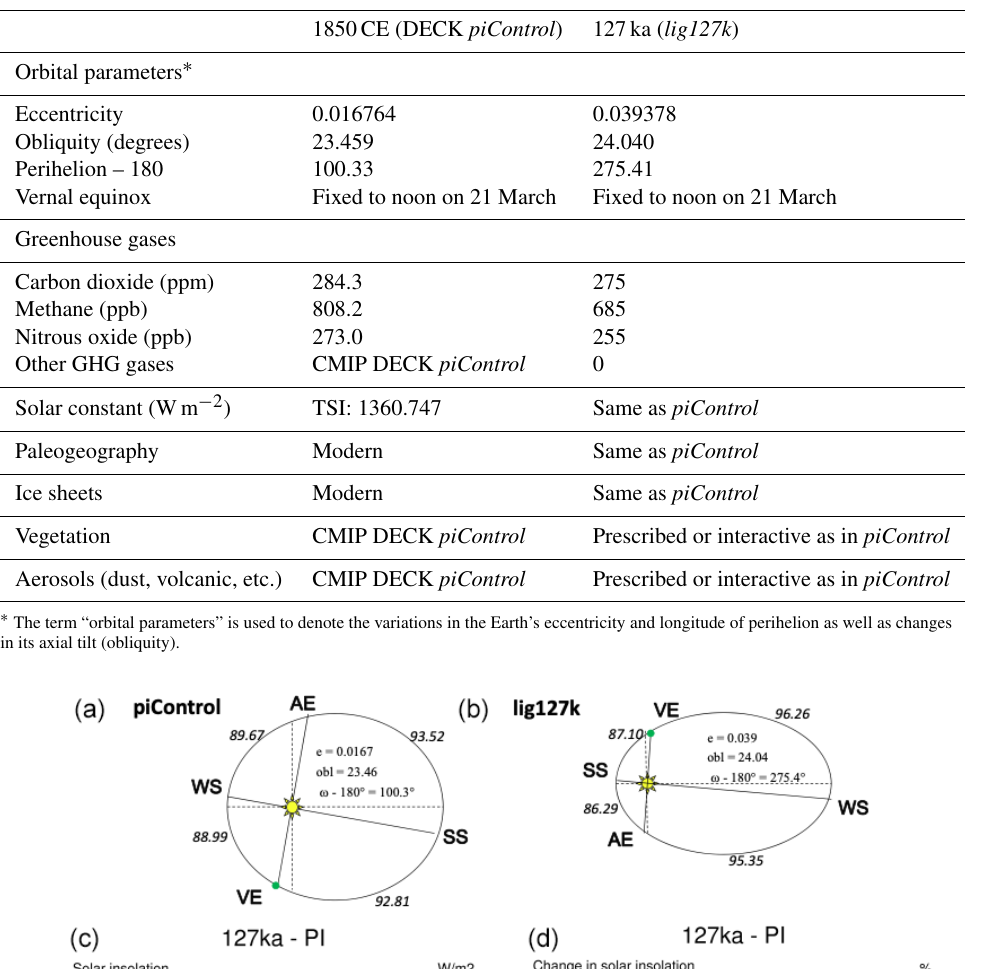
Table 1. Protocols: forcings and boundary conditions.